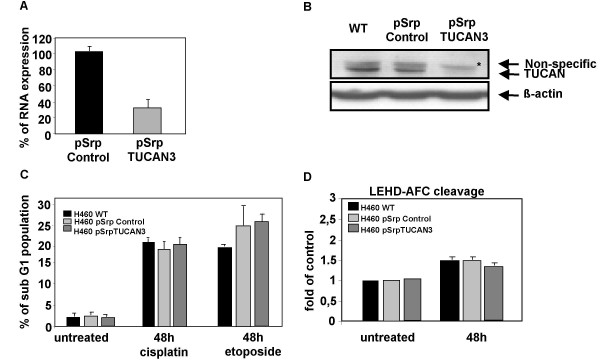
Effect of TUCAN down-regulation on cisplatin sensitivity in H460 cells. A) Real time RT- PCR experiment and B) Western blot analysis showing the silencing of TUCAN expression in H460 cells stably transfected with pSUPERretro TUCAN3 (pSrpTUCAN3). As control, a construct containing the reverse orientation of the RNA interference sequence, pSUPERretroTUCAN-control (pSrp control), was used. The mean ± SD of three independent experiments is shown, * – non-specific band. C) Cisplatin- and etoposide-induced apoptosis in H460 cells and derived transfectants. The percentage of cells in the sub-G1 fraction was taken as the apoptotic population. The results are depicted as the means of three experiments; bars, SD.D) activation of caspase-9 was measured by the cleavage of the fluorogenic substrate LEHD-AFC in H460 cells and derived transfectants exposed to cisplatin.